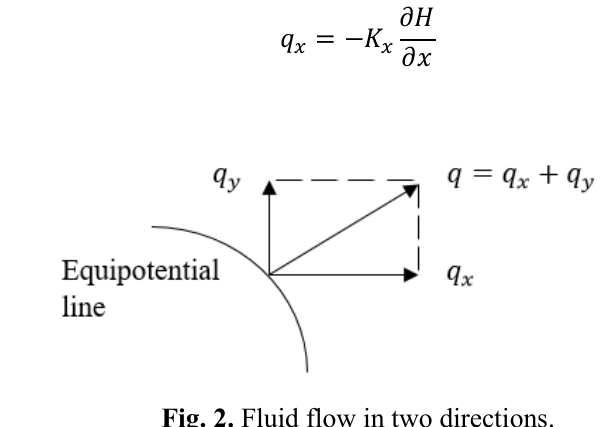
Fig. 2. Fluid flow in two